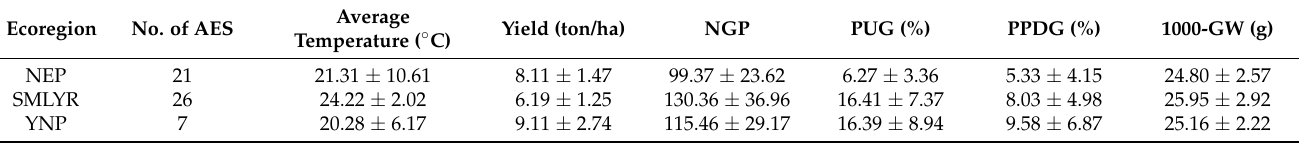
Table 1. Observed climate, rice yield and related variables from 148 weather stations and 54 agro- meteorological experimental stations across three ecoregions. Values are shown as mean ± standard